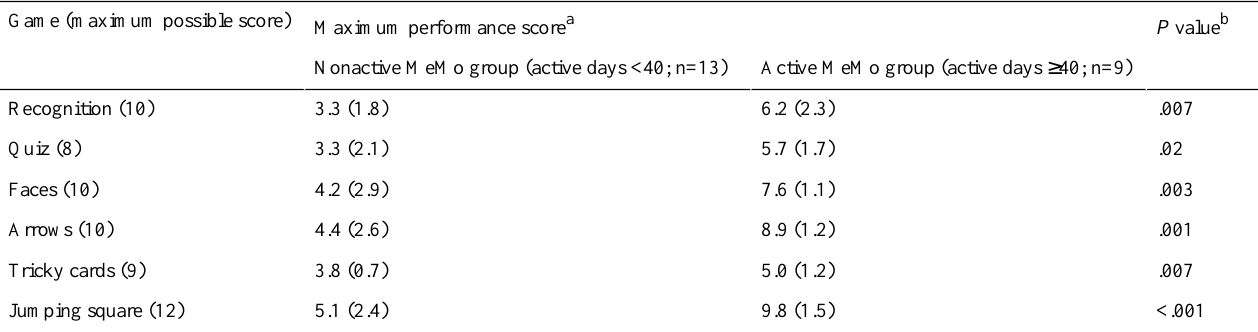
P value b Maximum performance score a Game (maximum possible